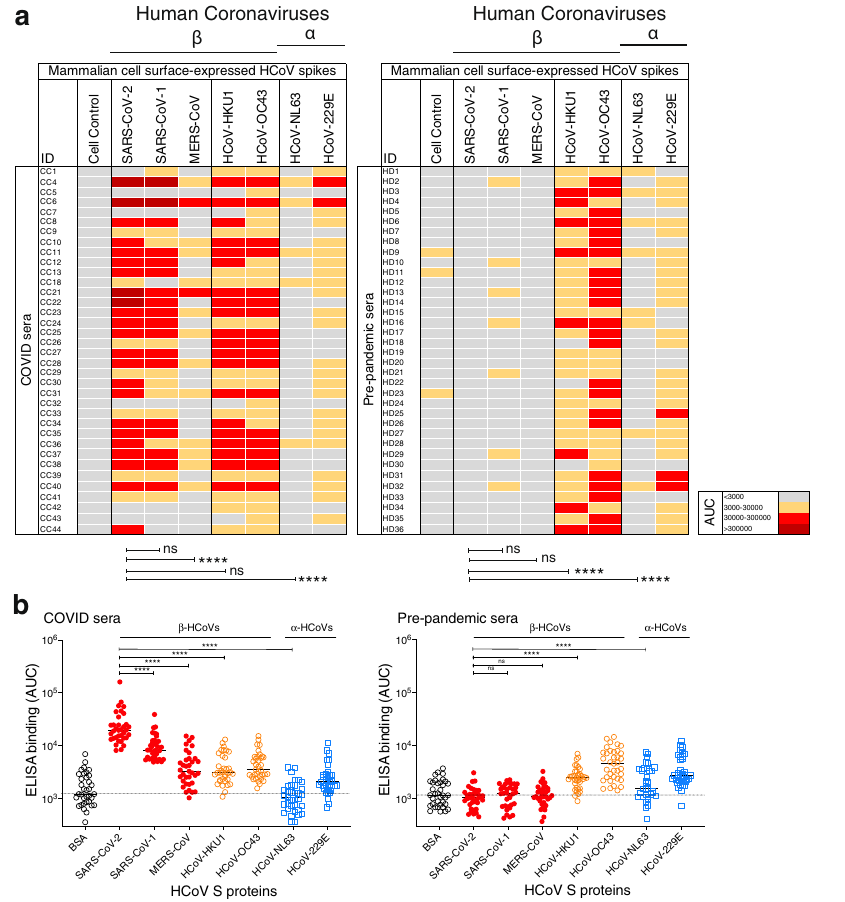
Fig. 1 Reactivity of COVID and pre-pandemic human sera with cell surface-expressed human coronaviruses spikes and their soluble S-protein versions. a Heatmap showing cell-based fl ow cytometry binding (CELISA) of COVID and pre-pandemic donor sera with 293 T-cell surface-expressed full- length spike proteins from β -(SARS-CoV-2, SARS-CoV-1, MERS-CoV, HCoV-HKU1, HCoV-OC43) and α -(HCoV-NL63 and HCoV-229E) human coronaviruses (HCoVs). Sera were titrated (six dilutions – starting at 1:30 dilution) and the extent of binding to cell surface-expressed HCoVs was recorded by % positive cells, as detected by PE-conjugated anti-human-Fc secondary Ab using fl ow cytometry. Area-under-the-curve (AUC) was calculated for each binding titration curve and the antibody titer levels are color-coded as indicated in the key. The binding of sera to vector-only plasmid (non-spike) transfected 293 T cells served as a control for non-speci fi c binding. b ELISA binding of COVID and pre-pandemic donor sera to soluble S-proteins from β - (SARS-CoV-2, SARS-CoV-1, MERS-CoV, HCoV-HKU1, HCoV-OC43) and α -(HCoV-NL63 and HCoV-229E) HCoVs. Serum dilutions (eight dilutions – starting at 1:30 dilution) were titrated against the S-proteins and the binding was detected as OD405 absorbance. AUC representing the extent of binding was calculated from binding curves of COVID (left) and pre-pandemic (right) sera with S-proteins and comparisons of antibody binding titers are shown. The binding of sera with each protein is shown as scatter dot plots with a line at median. Binding to BSA served as a control for non-speci fi c binding by the sera. The serum-binding experiments were carried out in duplicate and repeated independently at least once for reproducibility. Statistical comparisons between two groups were performed using a Mann – Whitney two-tailed test, (**** p < 0.0001; ns p >